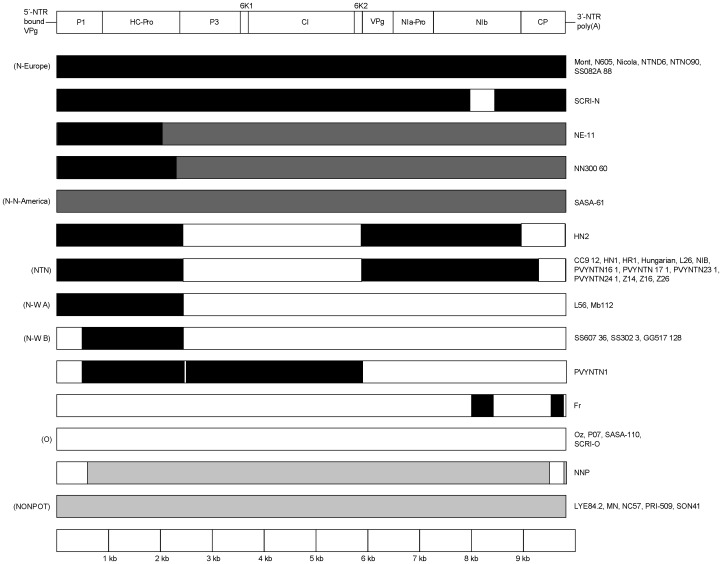
Recombination map of PVY genomes.Patterns of recombination between PVY strains PVYO (white), PVYN-North America (dark grey), PVYN-Europe (black) and PVYNONPOT (light grey) are illustrated.